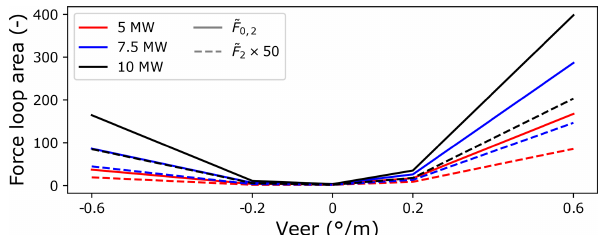
Figure 10. Non-dimensionalised, downwind-row, radial-load-loop- area results for various veer gradients for overhung ( ˜ F 0 , 2 ) and cen- tred ( ˜ F 2 ) main-bearing configurations across the three modelled tur- bines.